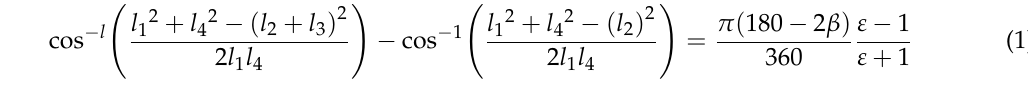
Table 1. Design parameters of the micro swing rotor engine in mesoscale.